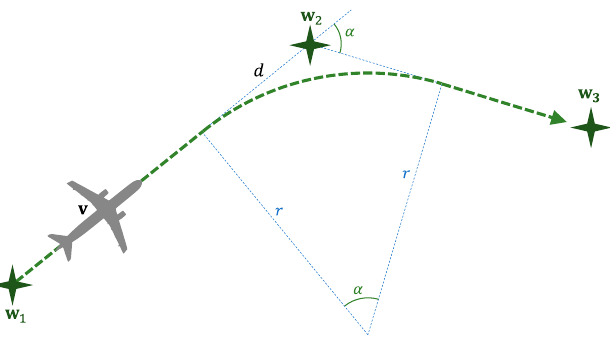
Figure 4. Distance-of-Turn Anticipation (DTA) concept.